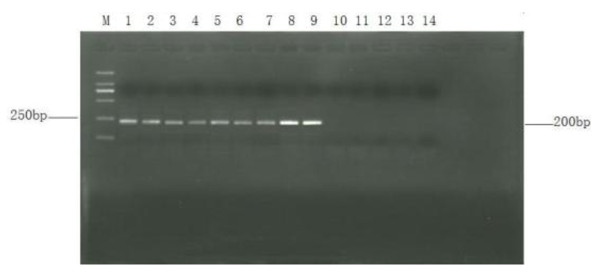
The second PCR amplification of the 5S-23S intergenic spacer region. Lanes 1-14:BO23: Borrelia. afzelii; B31: Borrelia.burgdorferi sensu stricto; SZ, T25, PBr, 20047, IP90, TN: Borrelia. garinii;VS116: Borrelia. valaisiana; Mycoplasma ovipneumoniane,, Chlamydia psittacii, Anaplasma marginale, Anaplasma ovis and pathogen-free tick DNA as negative controls.